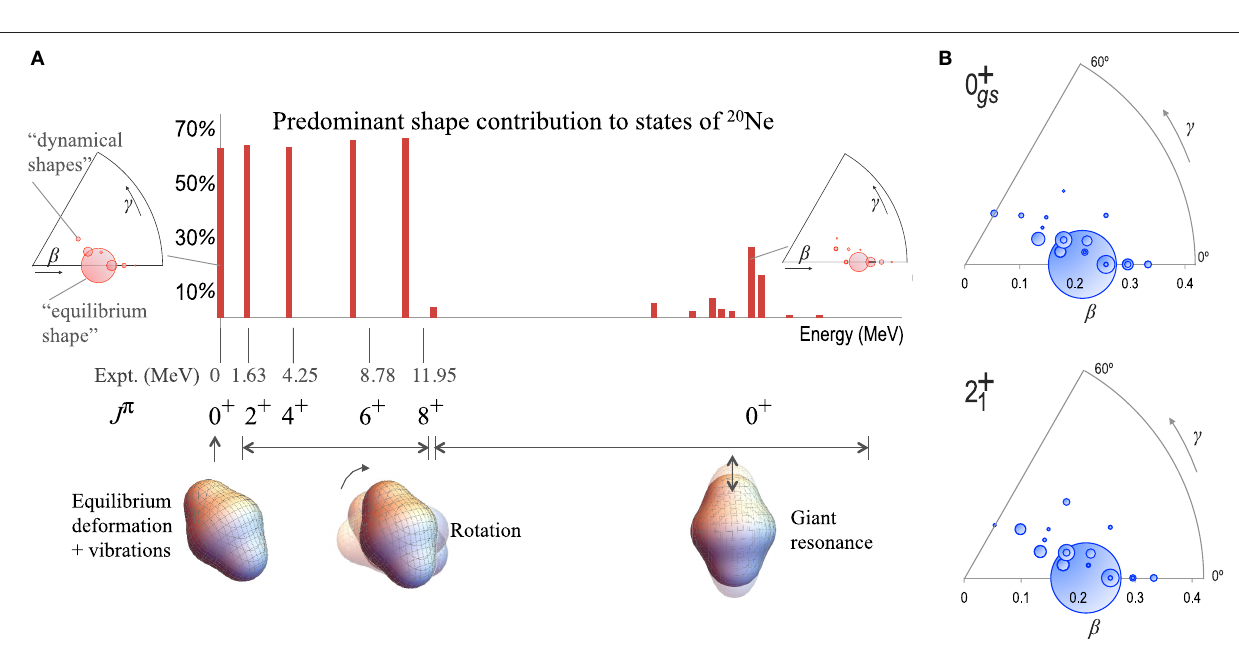
addressed either by using mean-field reference states with spontaneously broken symmetries (cf. section 2.3.4) or using correlated reference states in the first place (cf. section